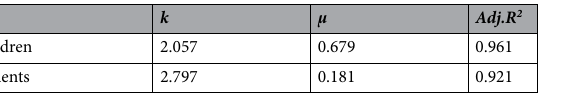
Table 3. Fitting results of the distribution of motion activation time of children and students.